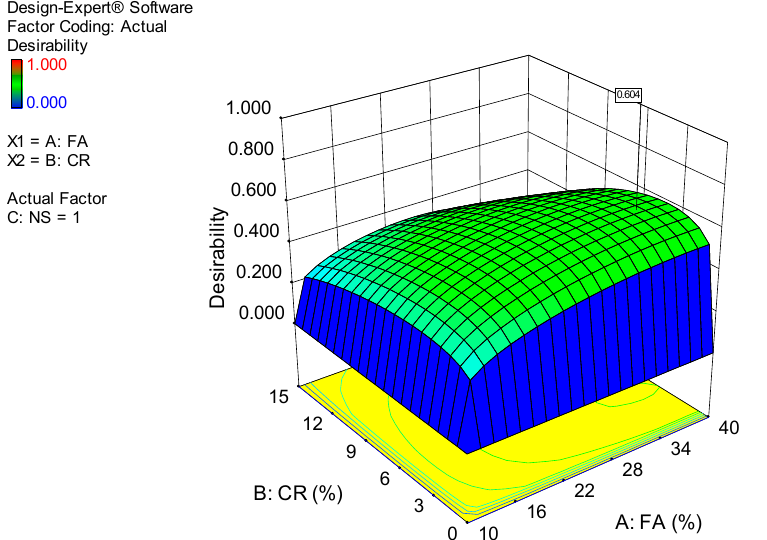
Figure 19. 3D response surface diagram for the desirability of the optimization.